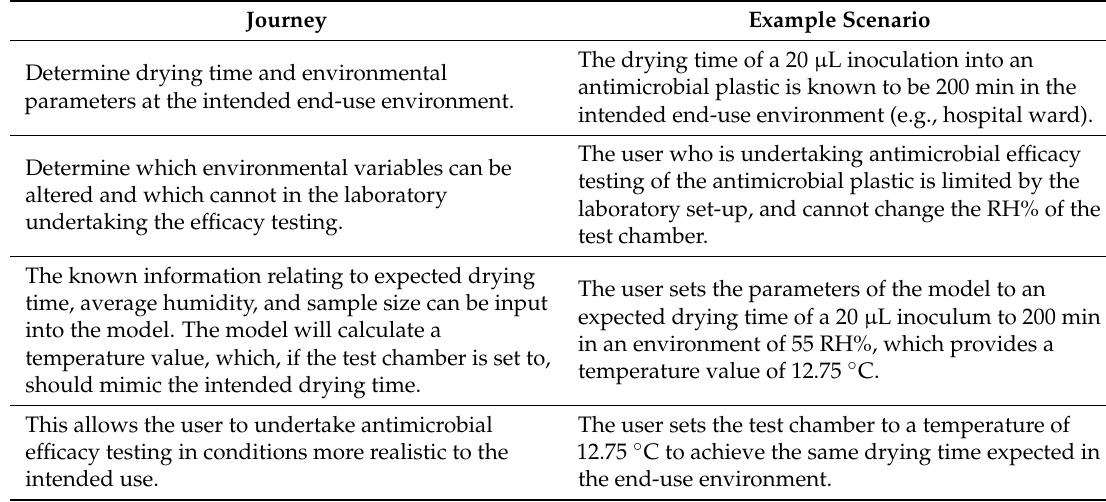
Table 2. Example user-journey whereby the user utilises the model to determine an experimental set-up which will provide a drying time similar to what may be expected in the intended end-use environment.